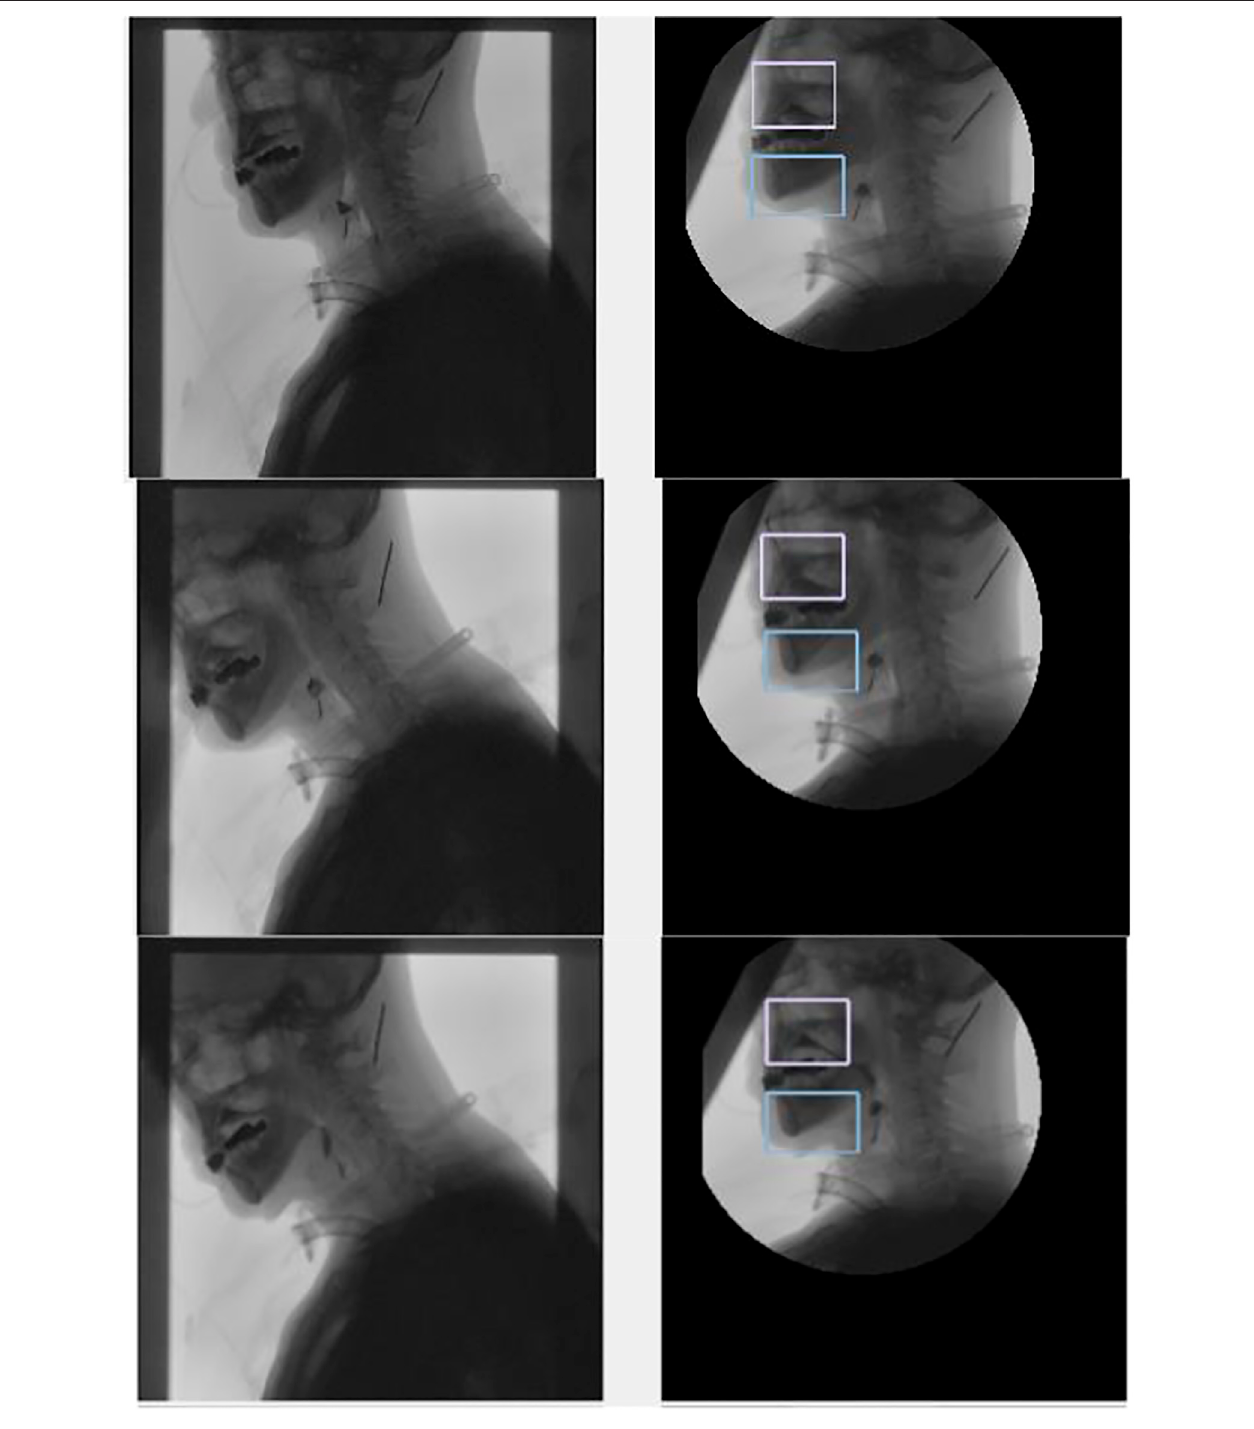
FIGURE 12 | Tracking the chin and nasal cavity. The left one is the original image, and the right one is the tracking results in the coordinate system of the spine.